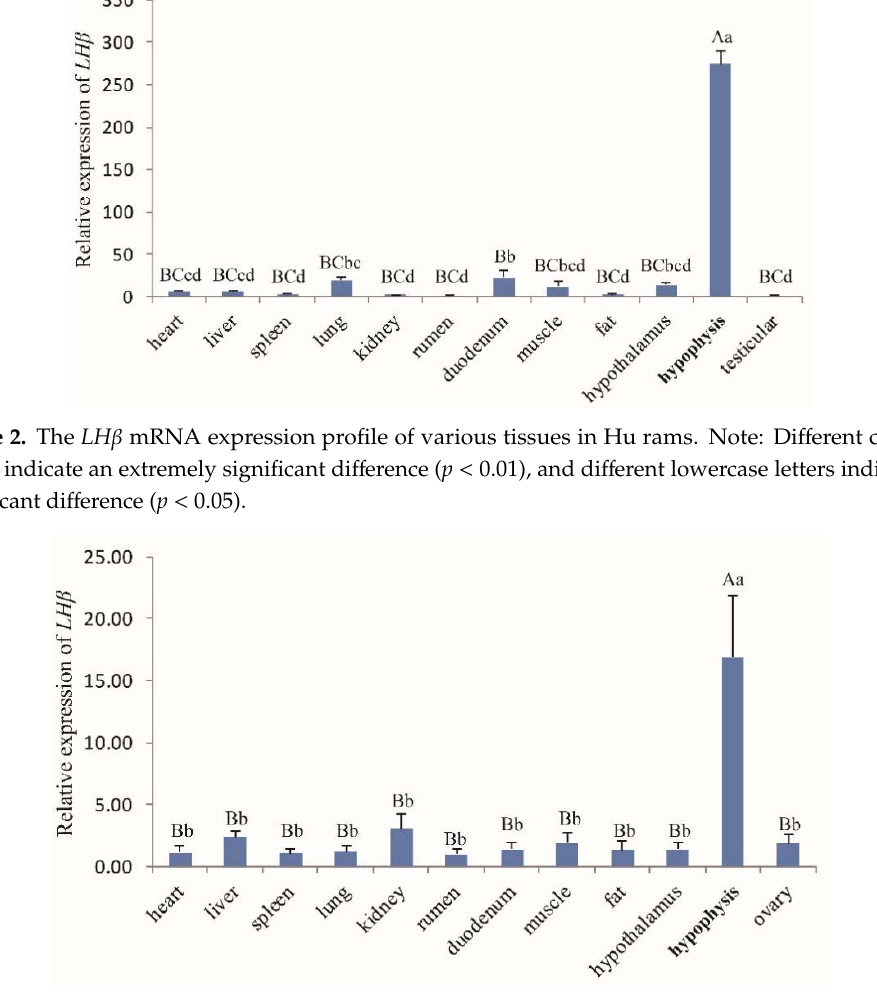
Figure 3. The LH β mRNA expression profile of various tissues in Hu ewes. Note: Different capital letters indicate an extremely significant difference ( p < 0.01), and different lowercase letters indicate a significant difference ( p < 0.05).